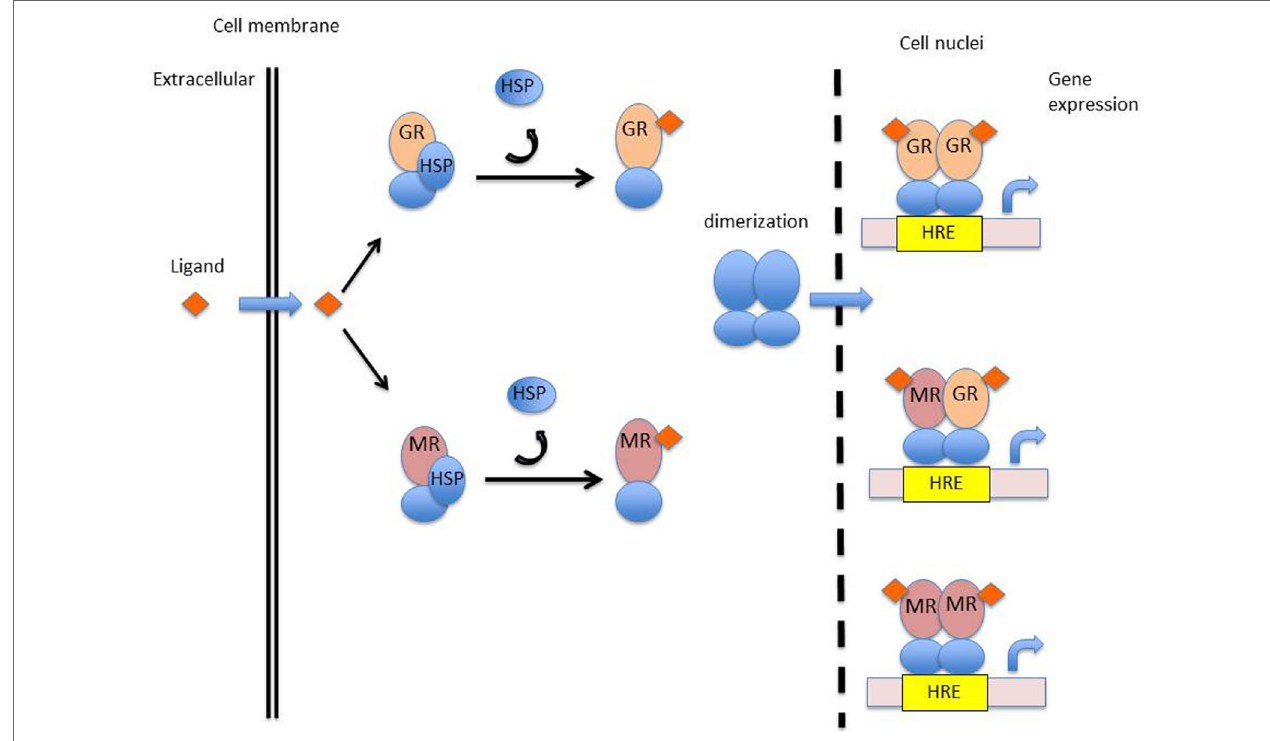
FigURe 2 | Mechanism of action of corticosteroids. Abbreviations: GR, glucocorticoid receptor; MR, mineralocorticoid receptor; HSP, heat-shock protein; HRE, hormonal response element.